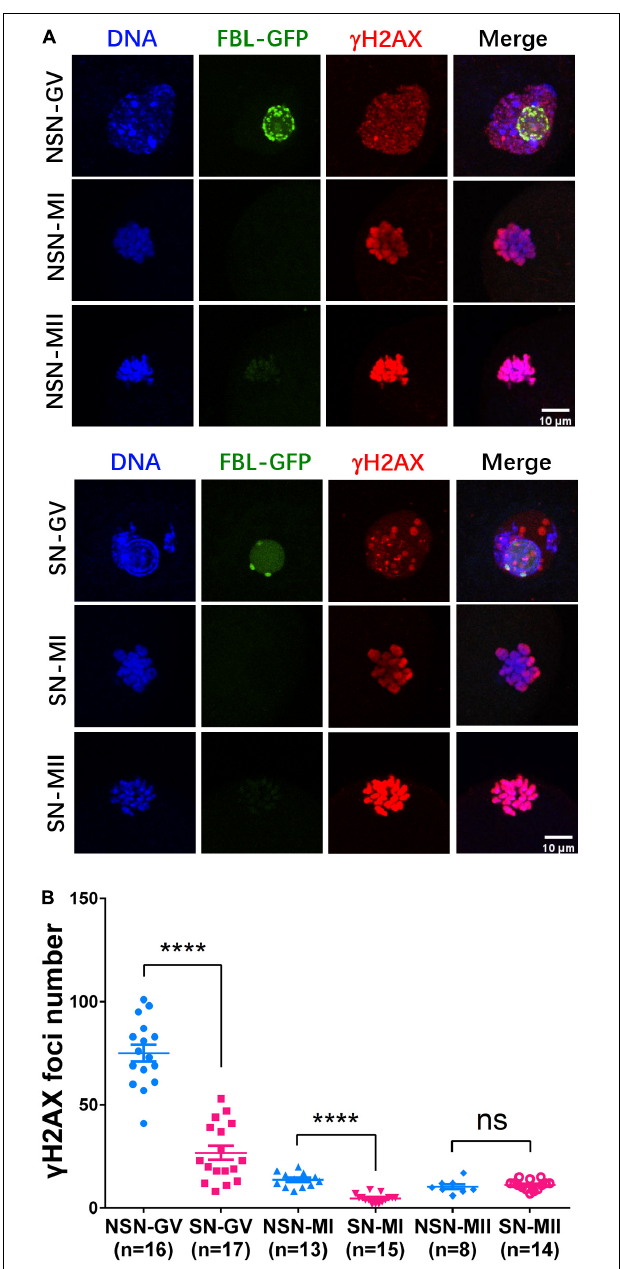
FIGURE 4 | H2AX phosphorylation dynamics during meiotic maturation. (A) γ H2AX staining in NSN and SN oocytes at GV, MI, and MII stage. Scale bars = 10 µ m. (B) The scatter plot shows the quantification of γ H2AX foci numbers in (A) . **** P <